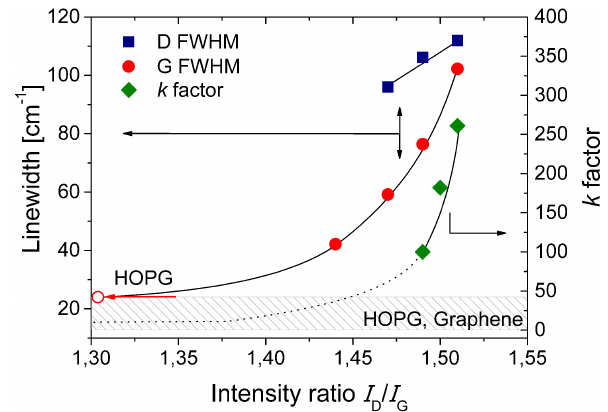
Figure 4. Correlation of Raman and piezoresistivity data for C/SiOC (13.5vol%C). The dashed area represents literature val- ues for k and Raman linewidth of highly ordered carbon (HOPG,